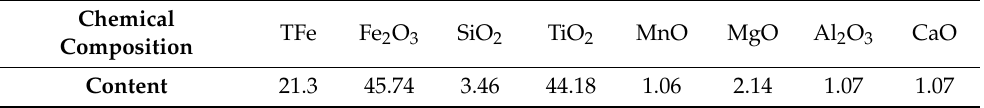
Figure 1. ( a ) XRD pattern and ( b ) EDS analysis of the ilmenite sample .